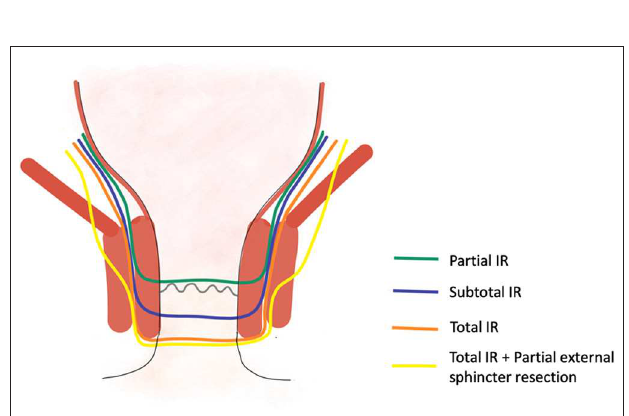
FIGURE 4 | Four different options of intersphincteric resection.